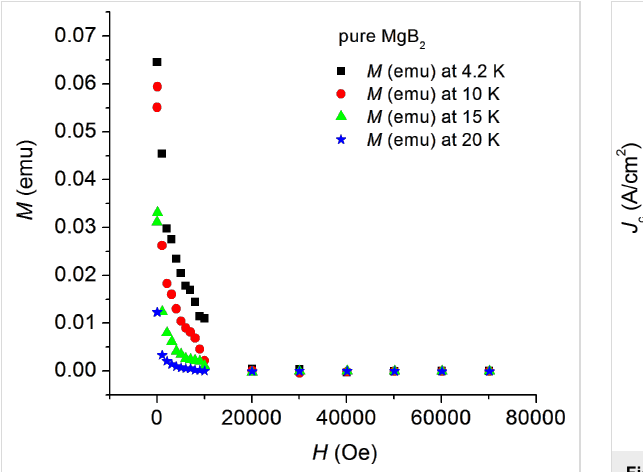
Figure 3: Magnetic-field dependence of the critical current density J c for the pure (red triangles) and for the FeO-covered (blue squares) MgB 2 samples at 4.2 K.